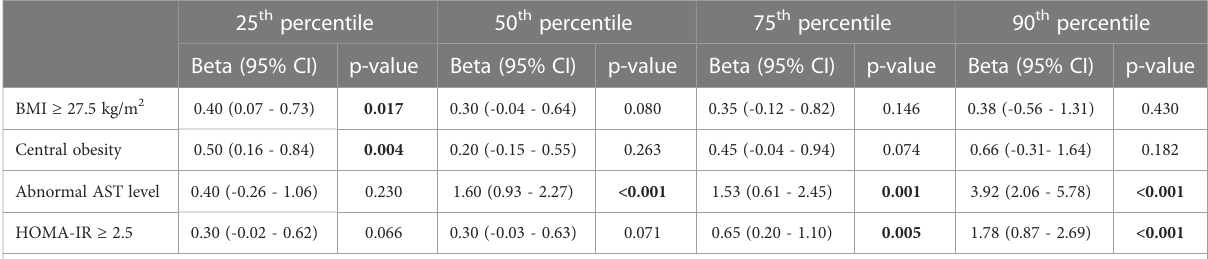
TABLE 3 Multiple quantile regression analysis showing the independent determinants of higher liver stiffness in participants with overweight/ obese MAFLD